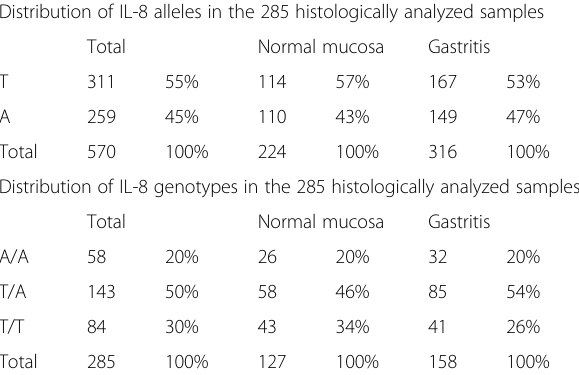
Table 2 Allele and genotype distribution of interleukin 8,